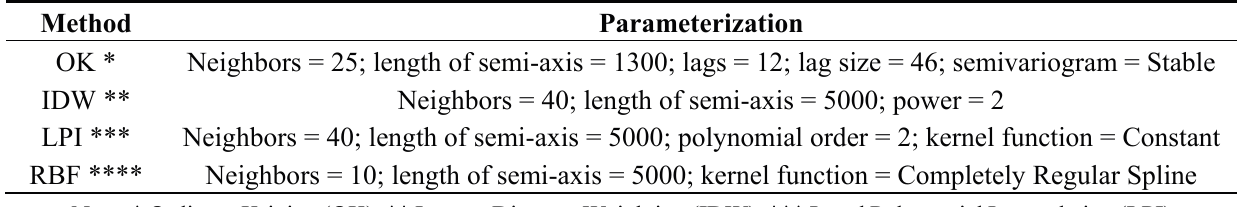
Figure 3. Bathymetric grids obtained from the different spatial interpolation methods: ( a ) Ordinary Kriging—OK; ( b ) Inverse Distance Weighting—IDW; ( c ) Local Polynomial Interpolation—LPI; ( d ) Radial Basis Function—RBF. Table 2. Summary of parameters used in the spatial interpolation